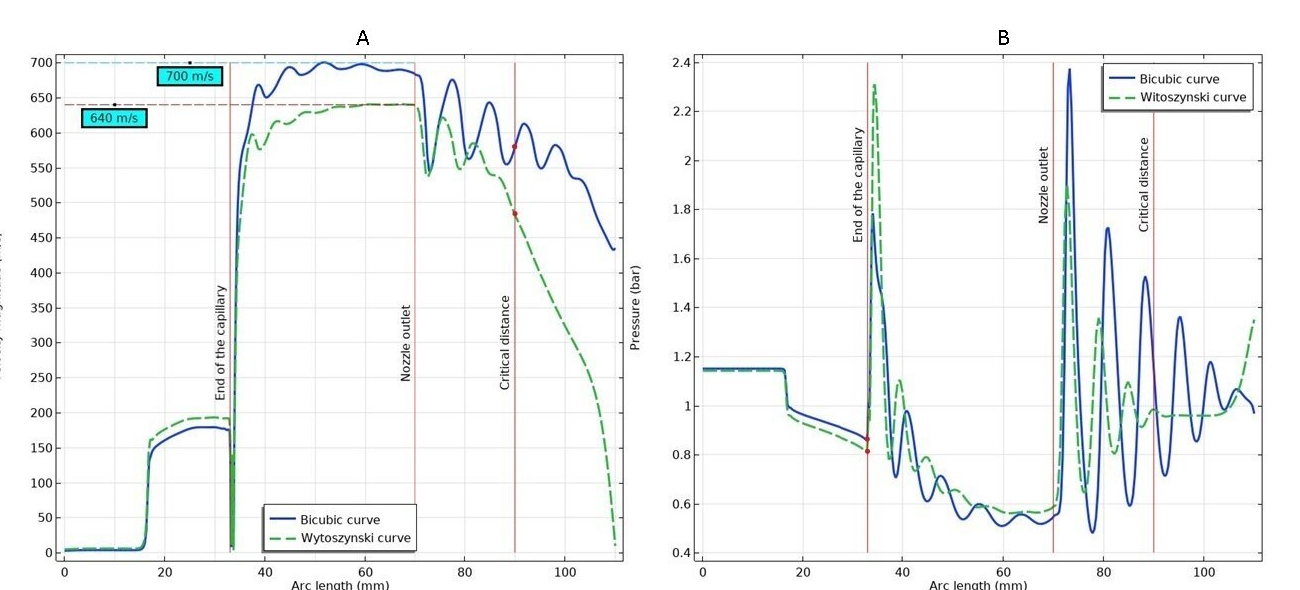
Figure 3. Comparison of the velocity ( A ) and pressure ( B ) of Bicubic and Witoszynski curve nozzles. The average flow velocity in the critical distance after exiting the outlet of the Bicubic curve nozzle is around 615 m/s. For the Witoszynski curve nozzle, the velocity is around 435 m/s. Fluctuations in velocity can be observed in both nozzles upon exiting the